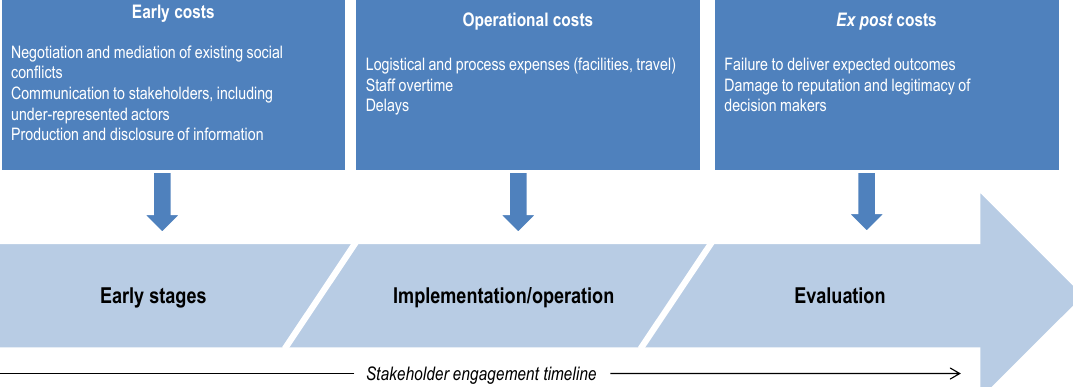
Figure 3. OECD typology of costs of stakeholder engagement in water governance [23].